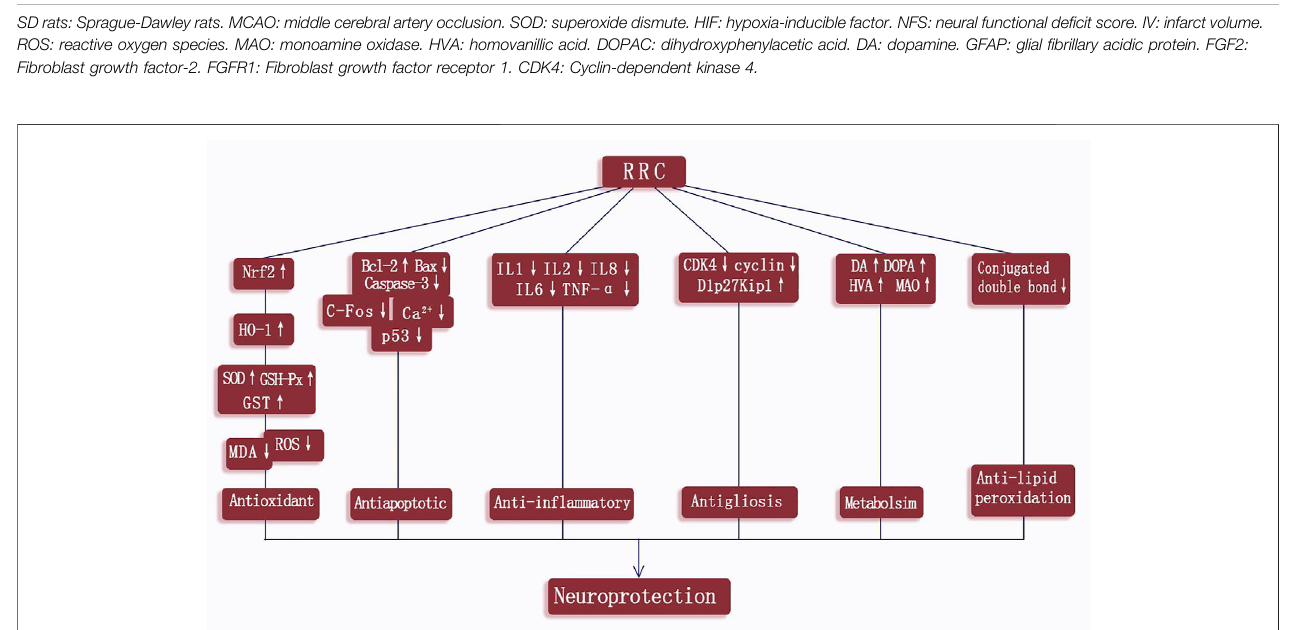
Frontiers in Pharmacology |